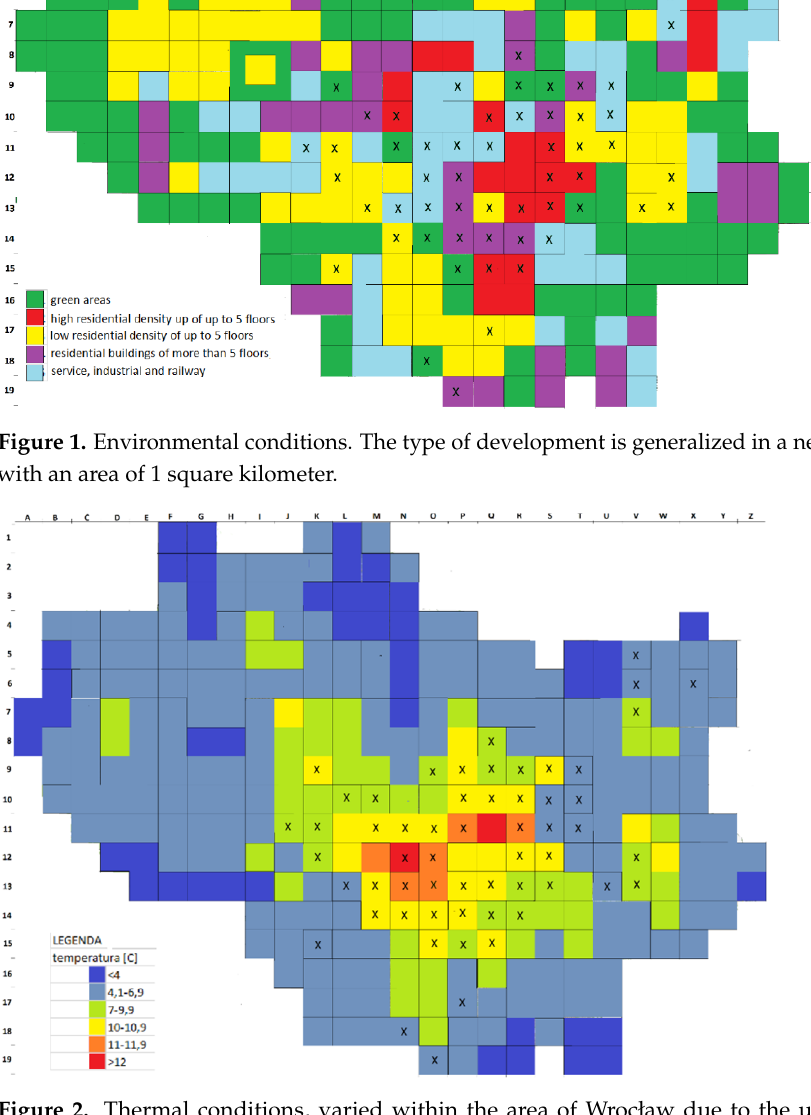
Figure 2. Thermal conditions, varied within the area of Wrocław due to the urban heat island generalized in a network of squares with an area of 1 square kilometre, in °C.